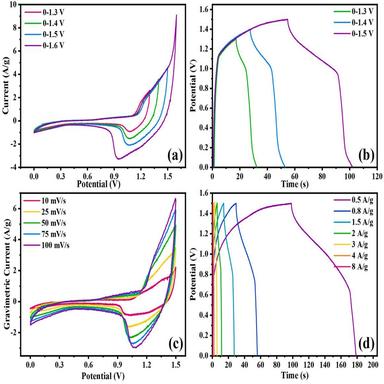
a, b) CV curves and GCD plots of the NiAl-LDH //AC asymmetric two-electrode cell at different voltage windows in 6 M KOH solution; (c) CV curves of the NiAl-LDH //AC at different scan rates; (d) GCD plots of the cell in various gravimetric currents.